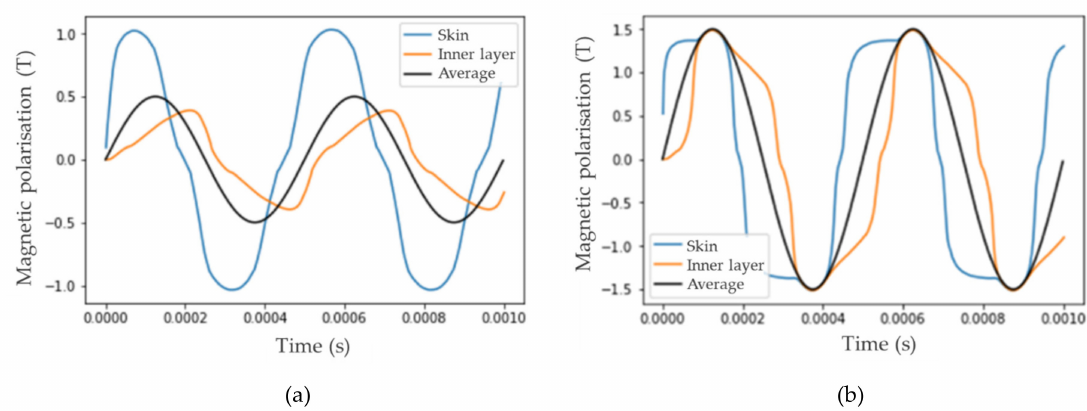
Figure 2. Flux density distribution within a lamination, when the average flux density is enforced to be a sinewave with ( a ) average Bpk = 0.5 T at a frequency of 2 kHz and ( b ) average B pk = 1.5 T at a frequency of 2 kHz.